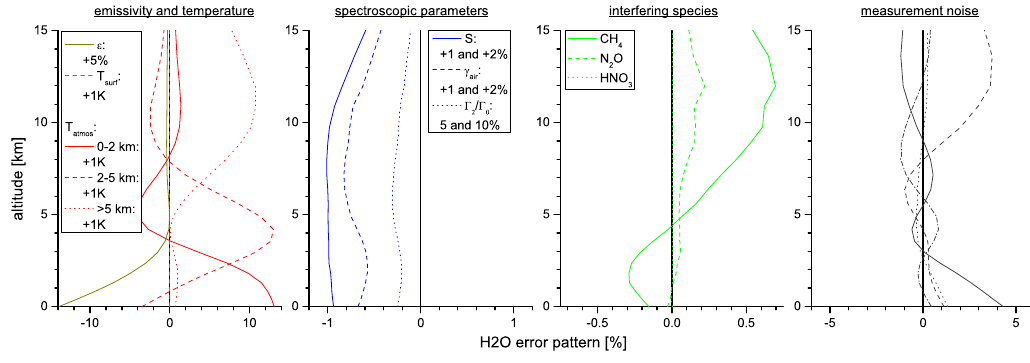
Fig. 4. H 2 O error patterns from the left to the right for different groups of uncertainty sources: emissivity ( † ) and temperature, spectroscopic line parameters ( S , γ air , and Γ 2 / Γ 0 ), interfering absorber (CH 4 , N 2 O, and HNO 3 ), and measurement noise, respectively.